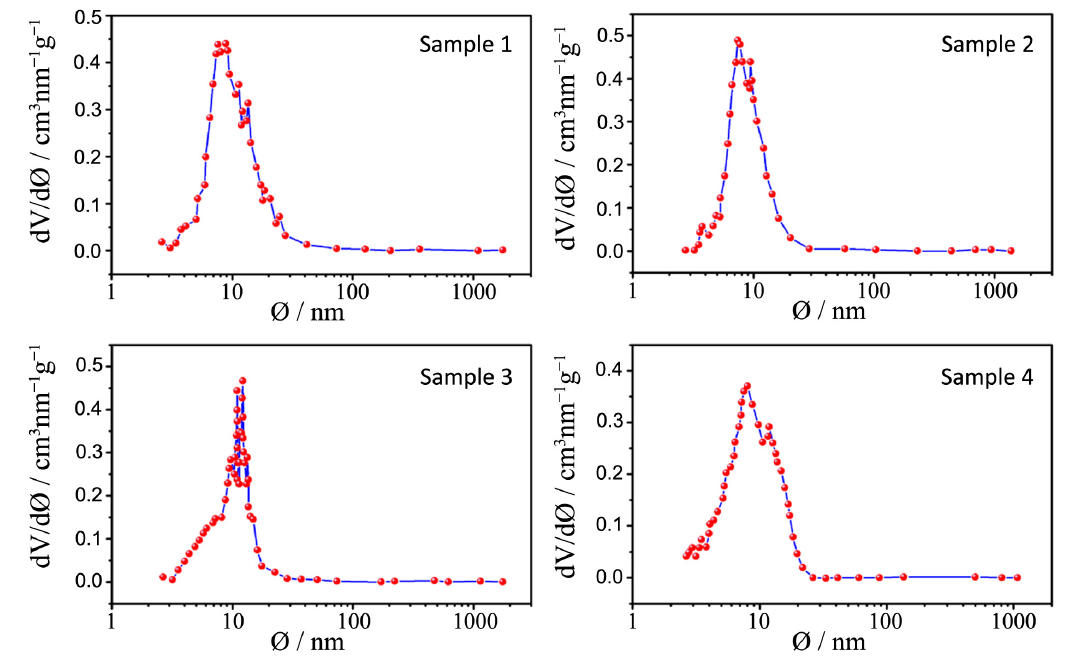
Figure 8. Pore size distribution plots for samples